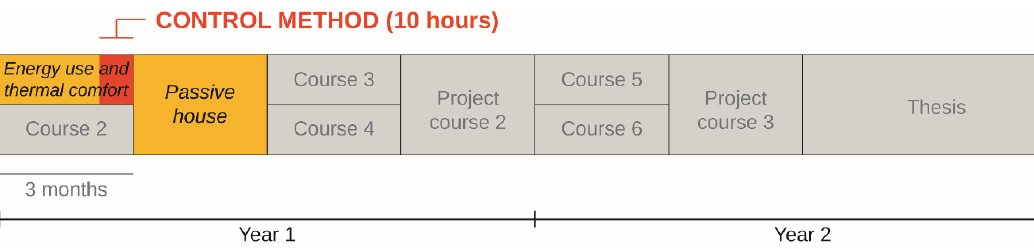
Figure 1. The structure of the examined Master Programme. This paper focuses on courses in yellow. The red box indicates the phase in which the control method is introduced.